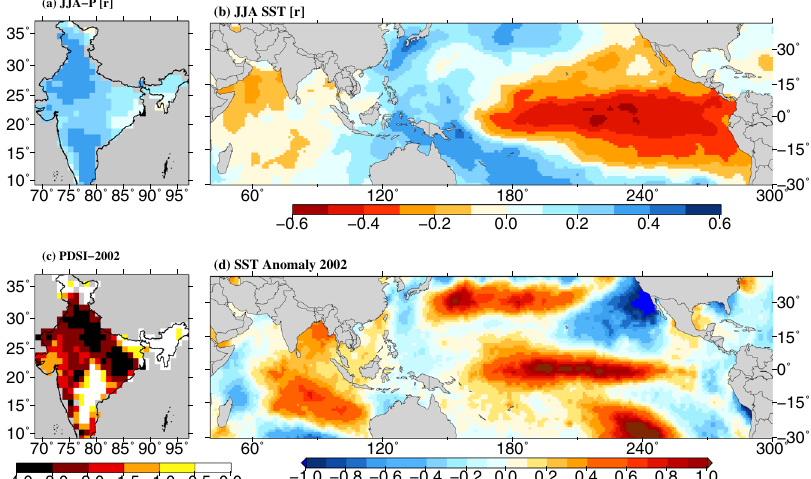
Fig. 4 The role of sea-surface temperature variability during the megadrought of 2002. a , b Heterogeneous correlation ( r ) patterns of coupled variability between the summer monsoon (June – August) precipitation and sea surface temperature (SST) obtained from the fi rst leading mode of maximum covariance analysis (MCA). MCA was conducted on JJA precipitation and SST anomalies during 1901 – 2018. c Palmer drought severity index (PDSI) for the megadrought of 2002, d sea surface temperature (SST) anomaly during the summer monsoon of 2002. Precipitation and SST were obtained from the climate research unit (CRU) and Hadley Centre (HadSST),